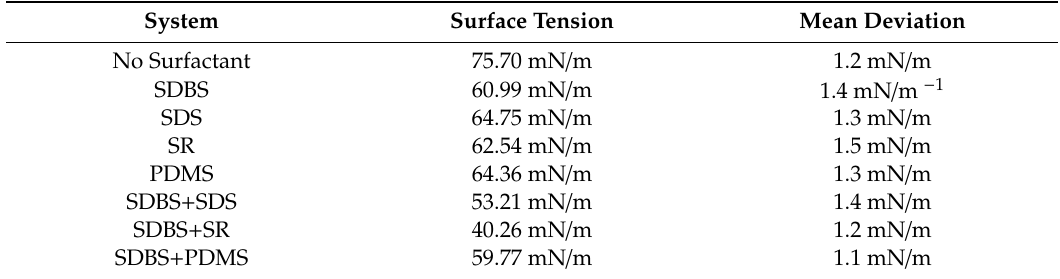
Table 4. Of the species of surfactant on the contact angle of the leaching solution of phosphate rock. System